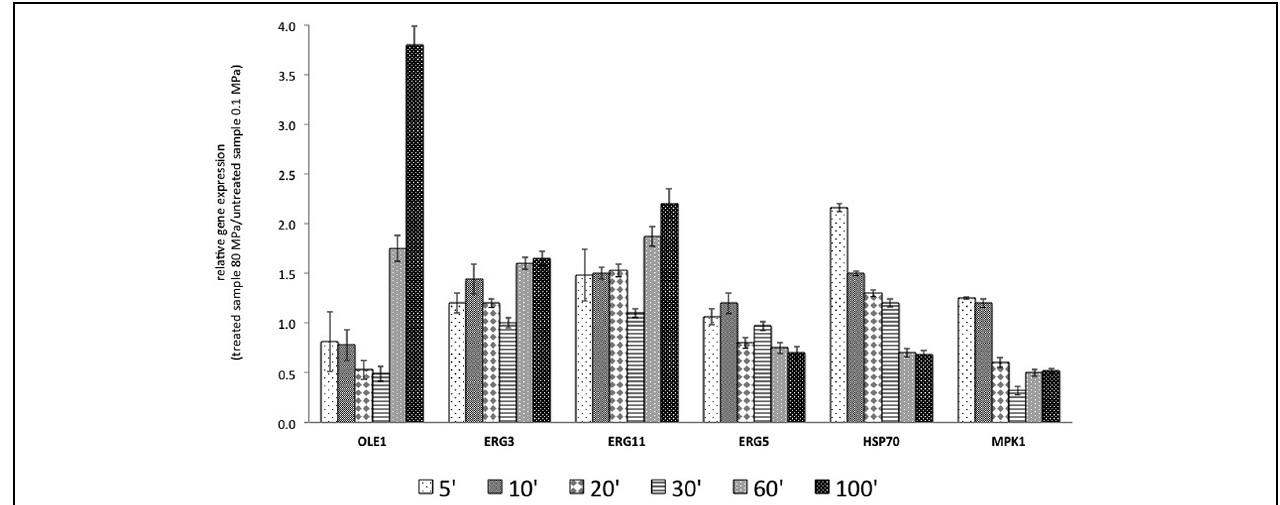
FIGURE 4 | Relative gene expression calculated with the samples treated at 0.1 MPa, as a control, and samples treated at 80 MPa, representing sub-lethal stress at 5, 10, 20, 30, 60, and 100 min after the start of treatment, in the presence of exogenous FAs (C18:1 and C16:1). The gene products included OLE1 , a delta-9 monounsaturated FAs desaturase; ERG3 , a C-5 sterol desaturase; ERG11 , a lanosterol 14-alpha-demethylase; ERG5 , a C-22 sterol desaturase; HSP70 , an hsp70 family ATPase; and MPK1 , a serine/threonine MAP kinase. The reported values are statistically significant ( p <